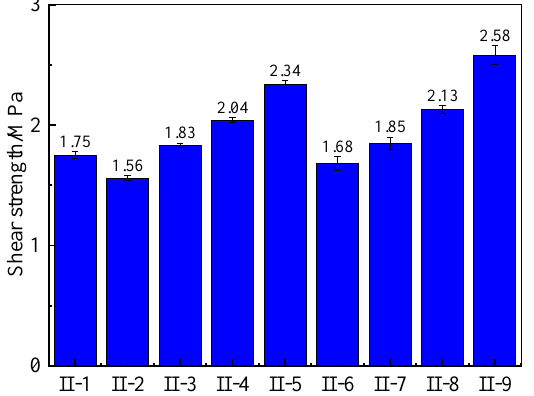
Figure 8. Shear strength of specimens.